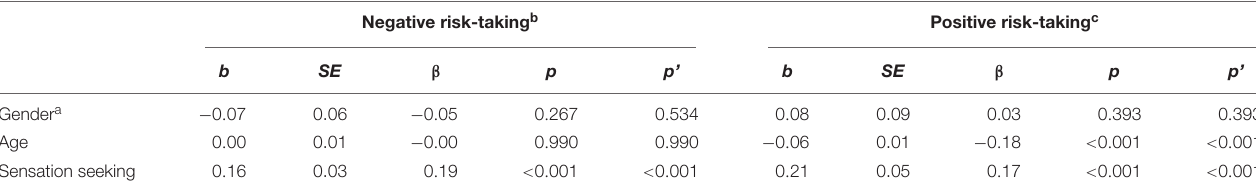
TABLE 2 | Coefficients for stepwise regression analyses with age, gender (step 1), and sensation seeking (step 2) as predictors of negative risk-taking and positive risk-taking. Negative risk-taking b Positive risk-taking